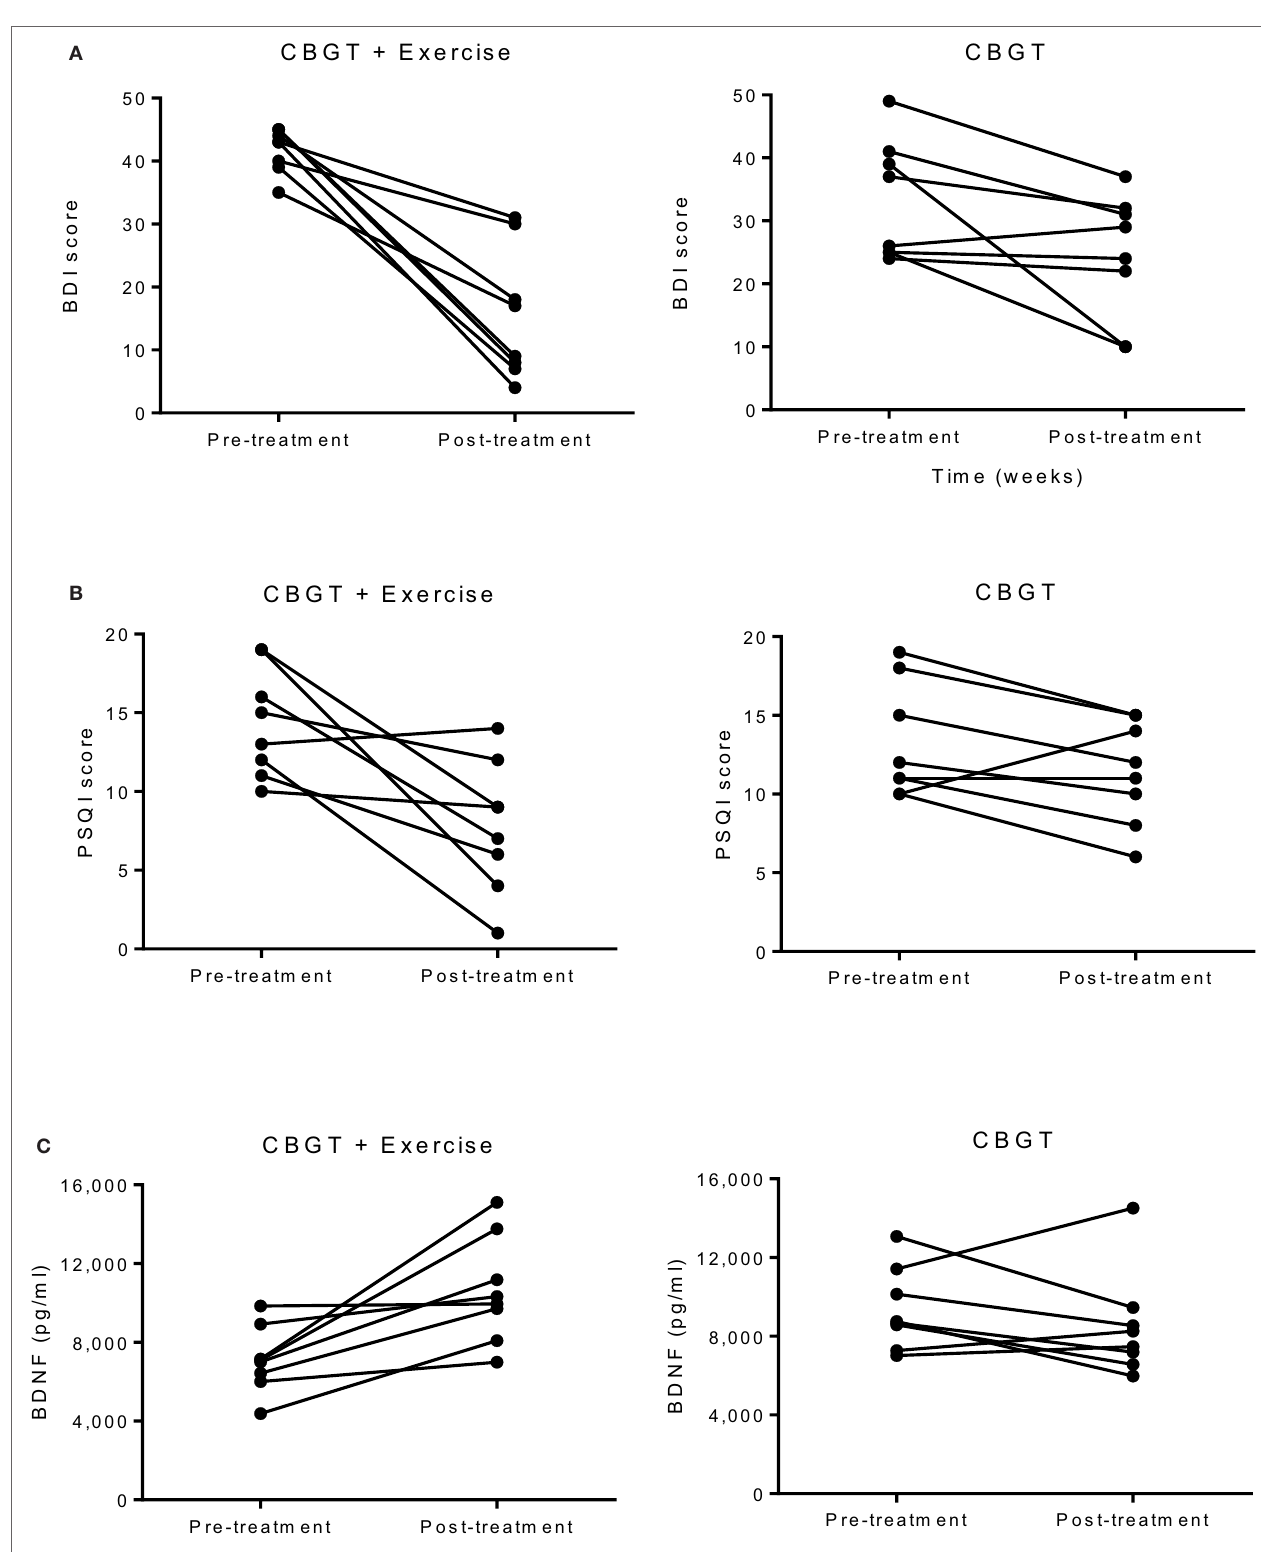
FigUre 1 | Individual group plots illustrating pre–post changes for (a) BDI depression scores, (B) PSQI scores, and (c) BDNF levels. BDI, Beck Depression Inventory; BDNF, brain-derived neurotropic factor; CBGT, cognitive behavioral group therapy; PSQI, Pittsburgh Sleep Quality